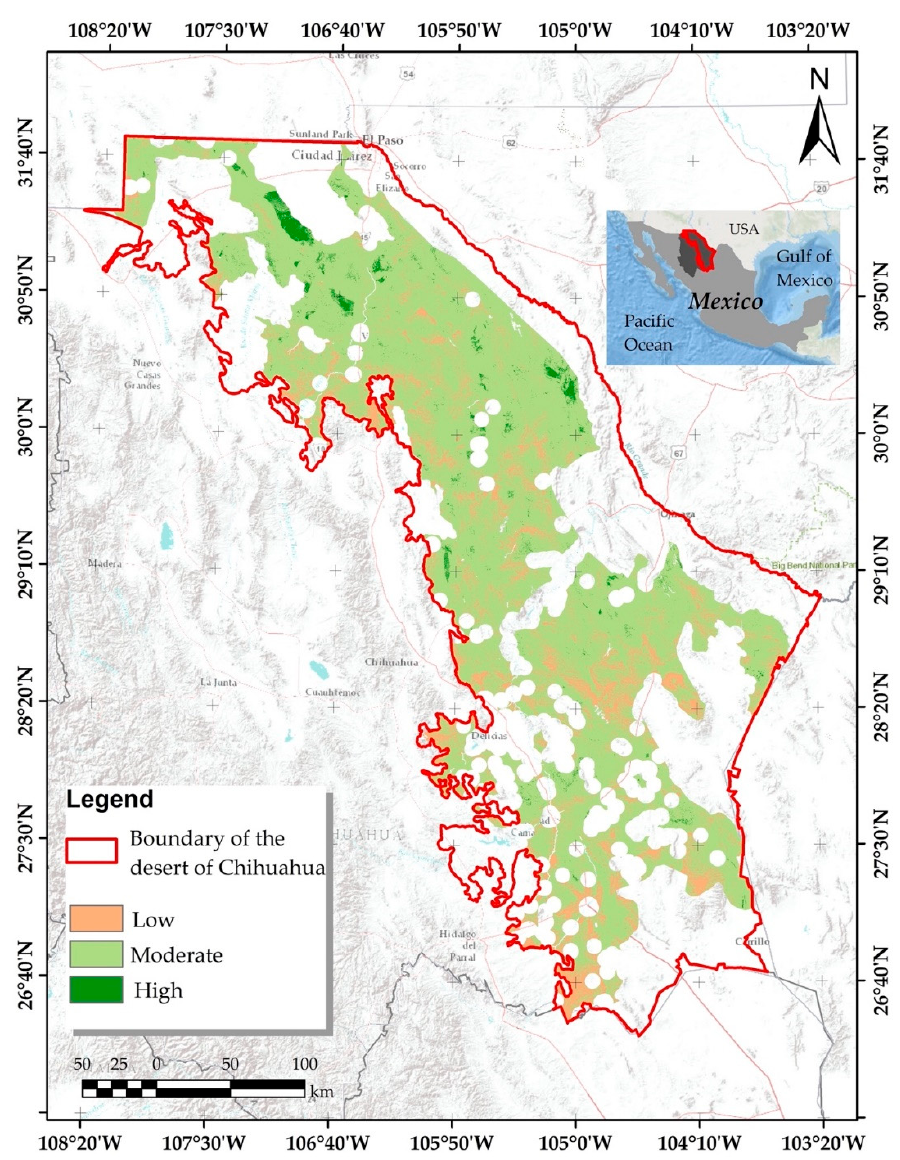
Figure 5. Spatial distribution of site-suitability levels for the development of solar farms in the Desert of Chihuahua. Ranking scenario. The non-colored sites within the study area correspond to restricted areas.